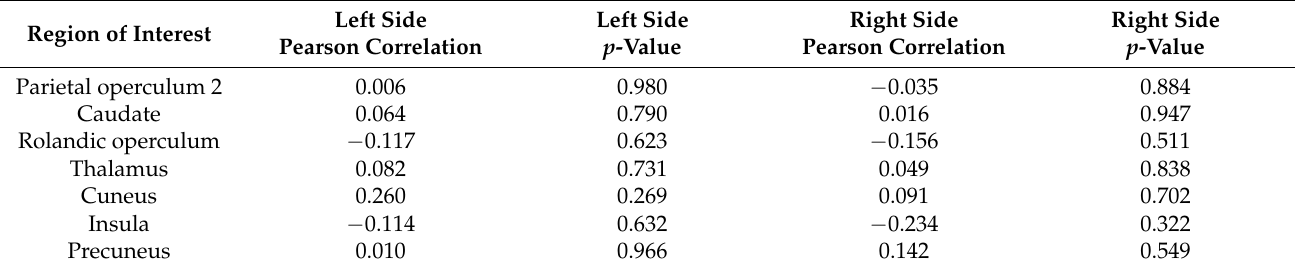
Figure 6. Correlation between metabolite levels and age in the parietal operculum 2. ( A ) Correlation between age and NAA/tCr of left parietal operculum 2. ( B ) Correlation between age and NAA/tCr of the right parietal operculum 2. ( C ) Correlation between age and tNAA/tCr of the right parietal operculum 2. ( D ) Correlation between age and Glx/tCr of the right parietal operculum 2. Abbrevia- tions: NAA, N-acetylaspartate; tNAA, total N-acetylaspartate; tCr, total creatine ratio; Glx, Glutamate and Glutamine. Table 4. Correlation Between GMV and Age a.